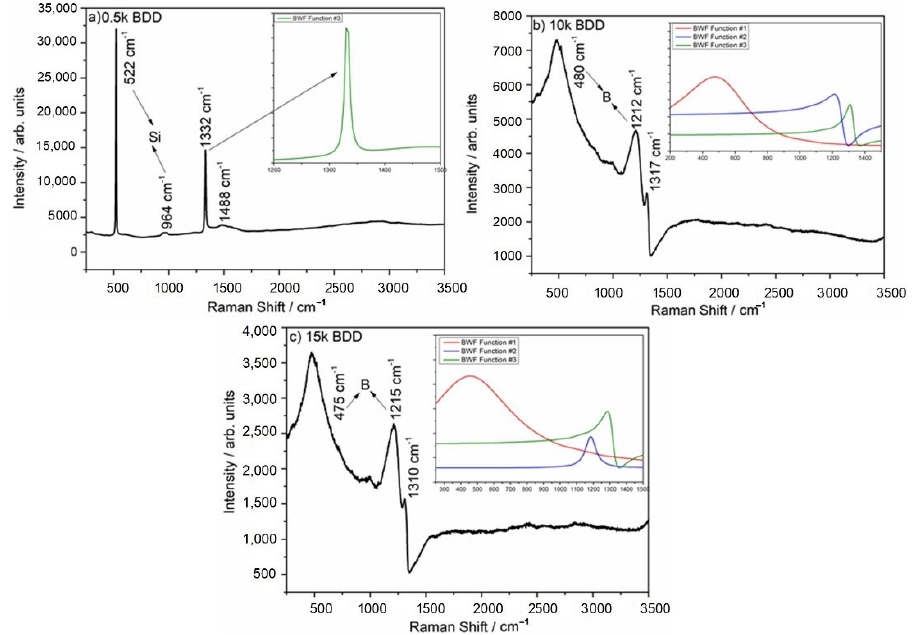
Figure 3. Raman spectra of ( a ) 0.5 k, ( b ) 10 k, and ( c ) 15 k BDD films. Insets shows Raman spectra modeled using Breit–Wigner–Fano function: Fano-shaped peaks (BWF #1 red line, BWF #2 blue line, and BWF #3 olive line). Table 2. Fitting parameters of BDD electrodes. Indices 1, 2, and 3 correspond to the BWF#1, BWF#2, and BWF#3 bands,